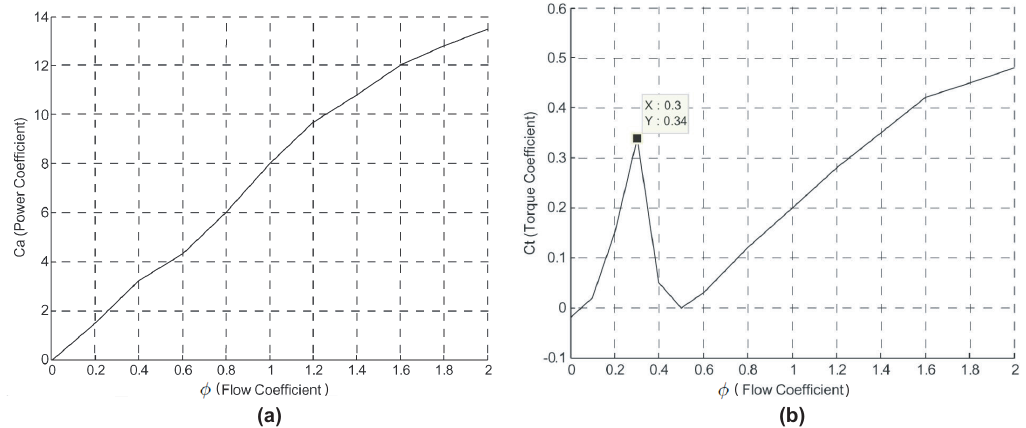
Figure 5. Characteristic curves of the installed Wells turbine. ( a ) Power coefficient versus flow coefficient; ( b ) torque coefficient versus flow coefficient.